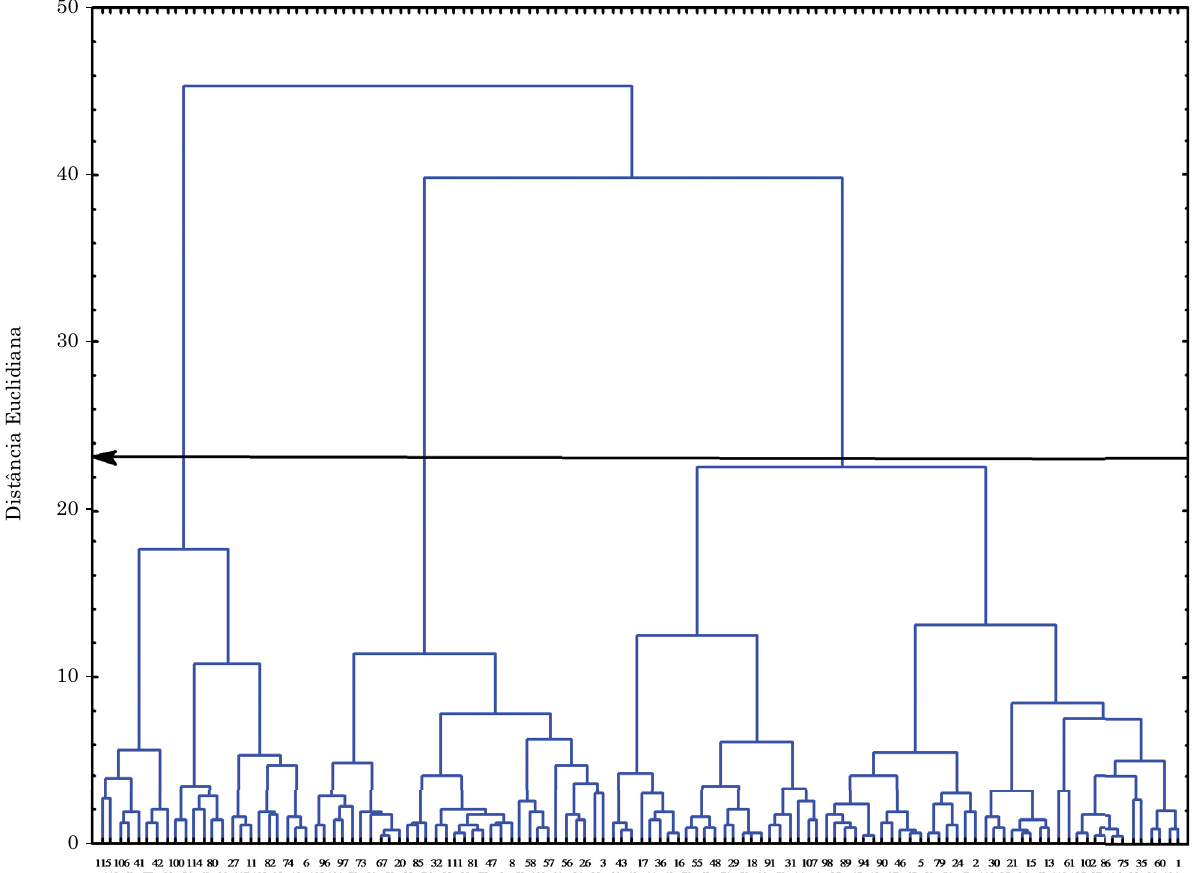
Figura 3. Dendrograma resultante da análise hierárquica de agrupamentos evidenciando a formação de grupos, segundo o número de vagens por planta, o número de grãos por vagem, o número de grãos por planta, a densidade do solo, a porosidade total, a umidade gravimétrica e a